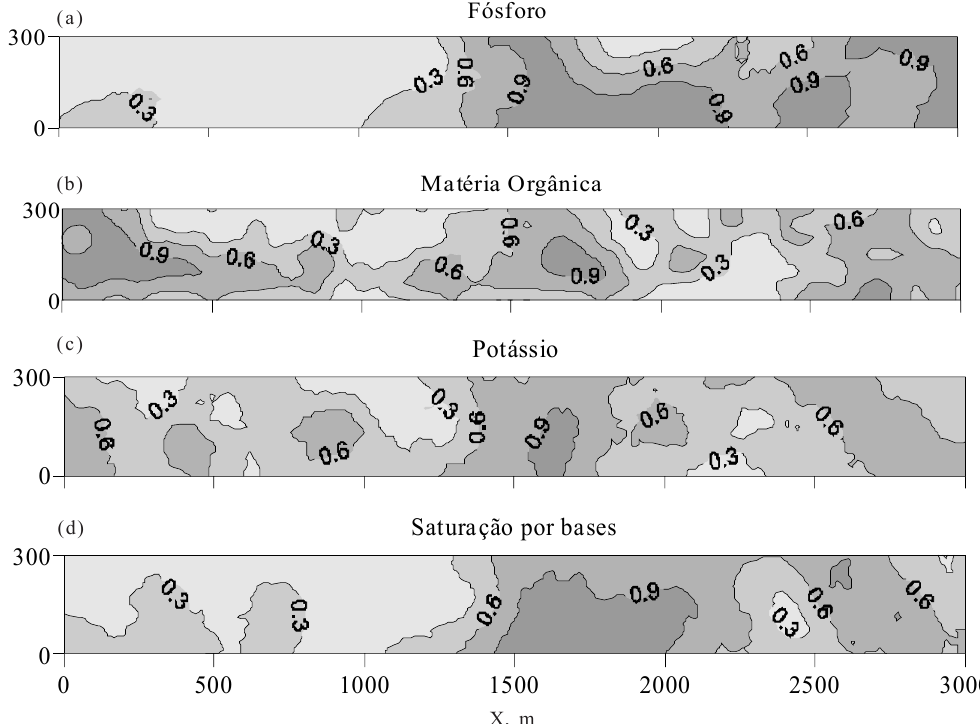
Figura 6. Mapas de probabilidade de as variáveis serem inferiores ou iguais aos valores de corte, correspondente ao seu respectivo 2 o quartil: (a) P[Z(u) ≤≤≤≤≤ 24,0]; (b) P[Z(u) ≤≤≤≤≤ 28,0]; )c) P[Z(u) ≤≤≤≤≤ 3,3]; e (d) P[Z(u) ≤≤ ≤≤ ≤